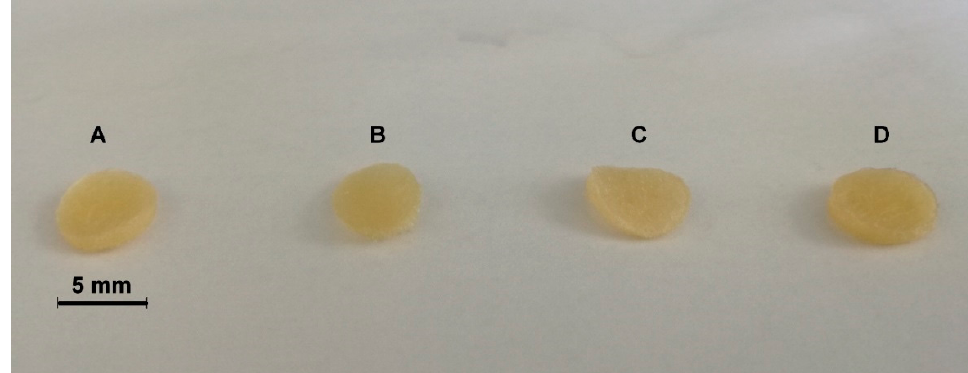
Figure 1. Photographs of ( A ) pure Lamina, ( B ) Lamina functionalized with 3-aminopropyl triethoxysilane (APTES) (see Experimental Section 2.2), ( C ) Lamina enriched with 5 µg/mL graphene oxide (GO) and ( D ) Lamina enriched with 10 µg/mL GO.